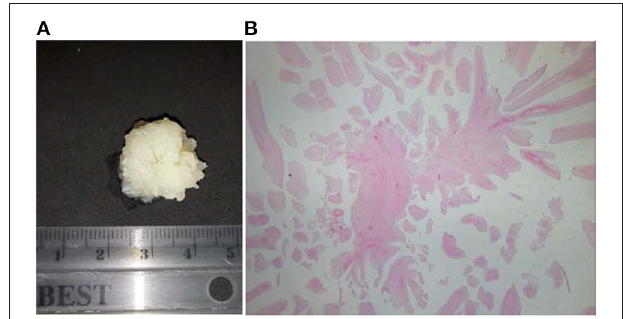
FIGURE 4 | Pathological exam of papillary fibroelastoma: (A) Gross specimen. (B) Histological finding stained by hematoxylin-eosin method (a fragment from a tumor nodule constructed of numerous papillary formations lined with endothelial cells while a stromal papilla is constructed of a homogeneous, hypocellular portion of edematous connective tissue) on a low magnification.